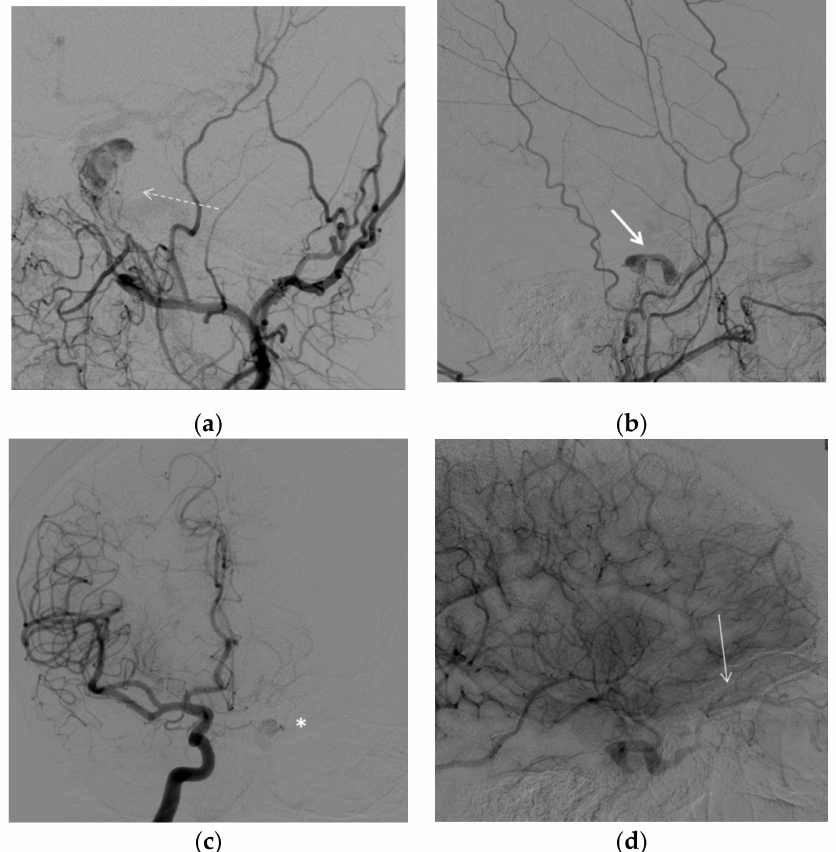
Figure 3. DSA. ( a ) Left external carotid artery, anterior oblique view showing several, tiny branches from the internal maxillary artery feeding the CS-DAVF (dashed arrow). ( b ) Left external carotid artery, lateral view, demonstrating early opacification of the left cavernous sinus (arrow) due to the dural fistula. ( c ) Right internal carotid artery, antero-posterior view. Small branches from the carotid syphon converge to the contralateral cavernous sinus (asterisk) through the intercavernous plexus. ( d ) Right internal carotid artery, latero-lateral view, late phase. The retrogradely opacified left superior ophthalmic vein is proximally enlarged and slightly pinched where it crosses the superior rectus muscle